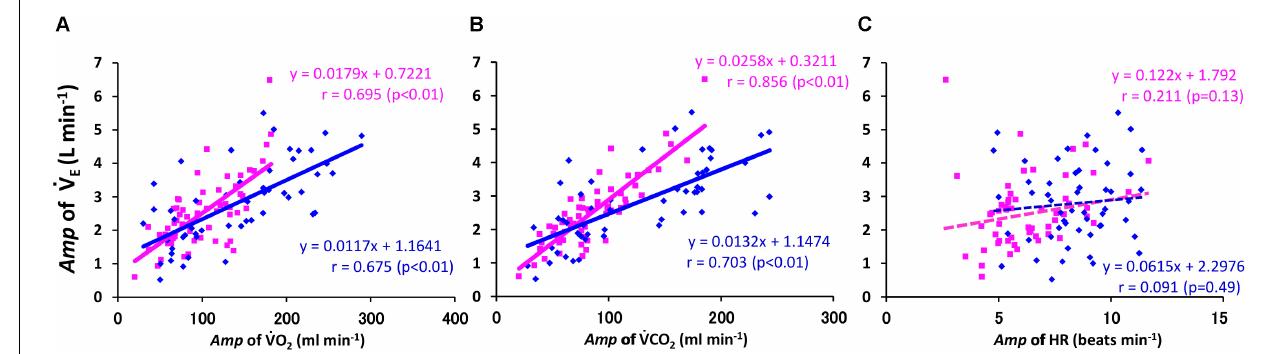
FIGURE 5 | Relationship between Amp of the ˙V E and ˙VO 2 (A) , ˙VCO 2 (B) , and HR (C) . Note that the Amp for the ˙V E kinetics followed the Amp for the ˙VCO 2 kinetics more closely. The regression line for the Amp of the ˙V E –˙VCO 2 relationship was steeper in the ELD than in the YG. YG; y = 0.0132 x + 1.147, r = 0.703 ( p < 0.01, A ),